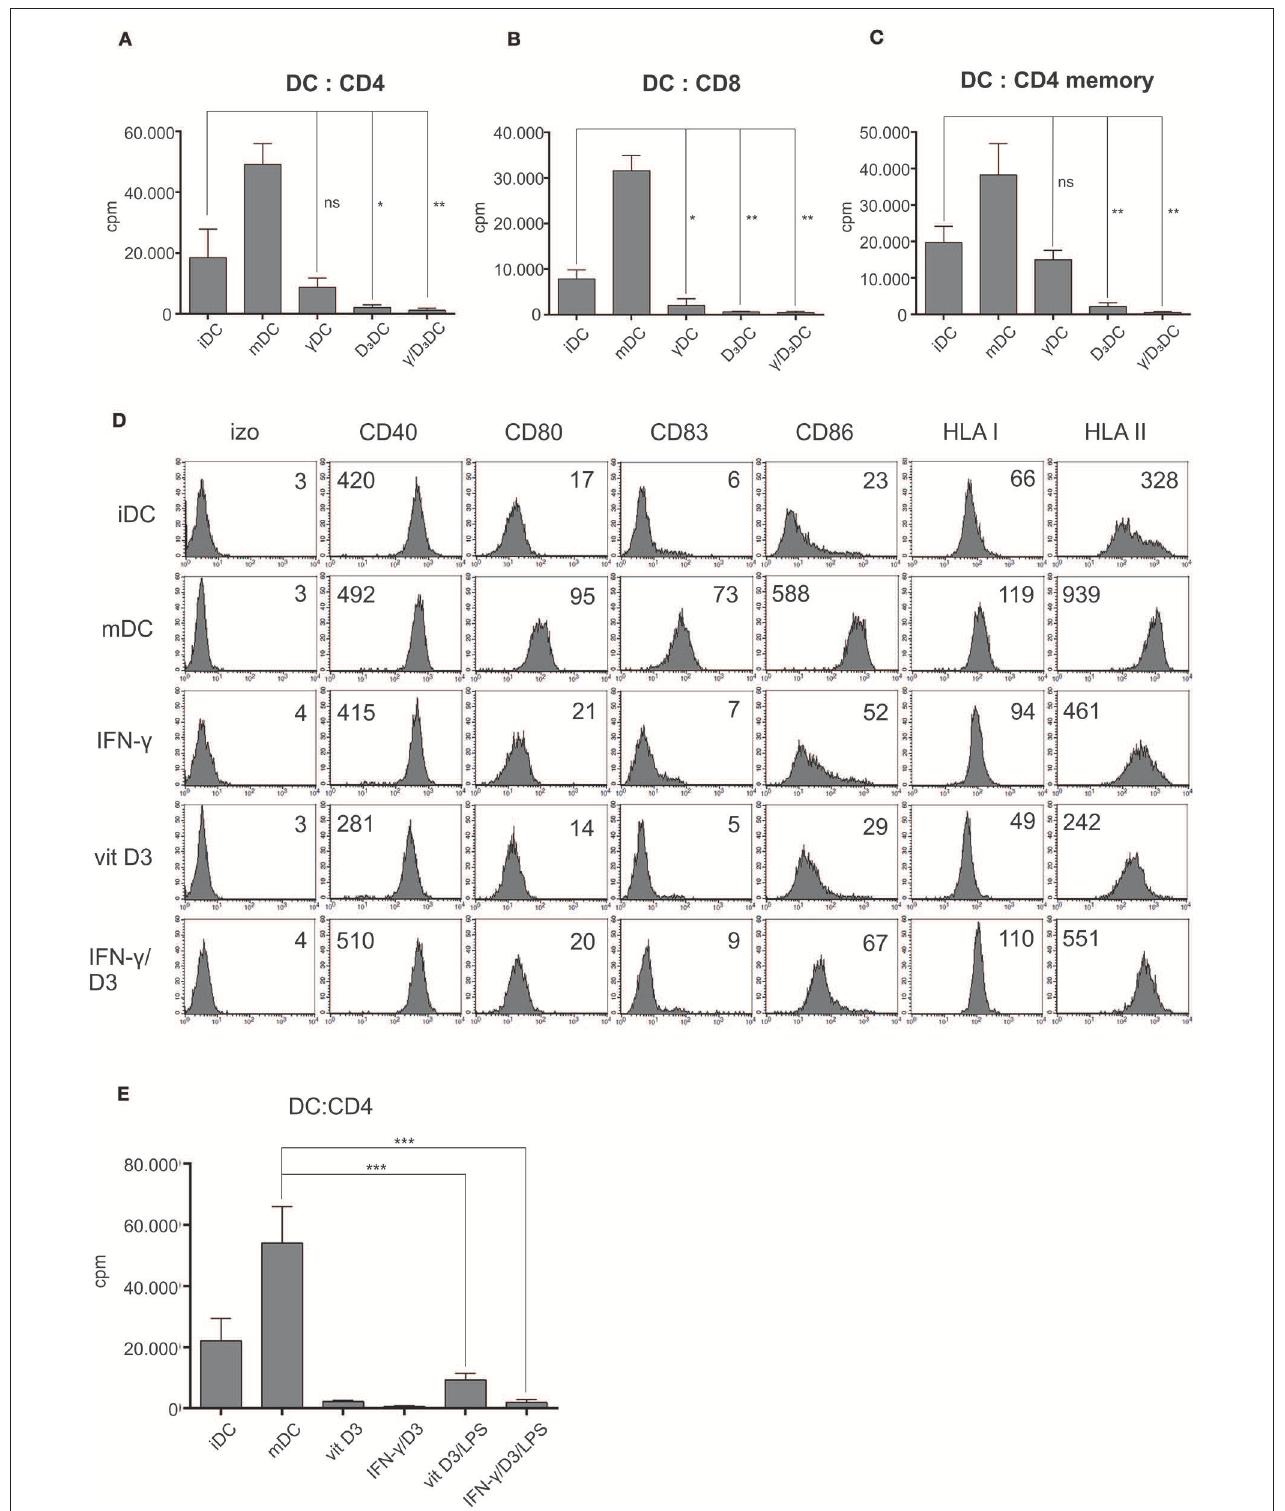
FIGURE 3 | γ /D 3 DCs possess low allo-stimulatory and co-stimulatory potential. Dendritic cells were prepared as described in section Materials and Methods. and used as stimulators in an allogeneic co-culture with (A) whole CD4 + T cells, (B) whole CD8 + T cells, or (C) memory CD4 + T cells. The co-cultures were prepared in 96-well flat bottom plates. After 4 days, the wells were pulsed with tritium-labeled thymidine and proliferation was measured after 18–22h by liquid scintillation